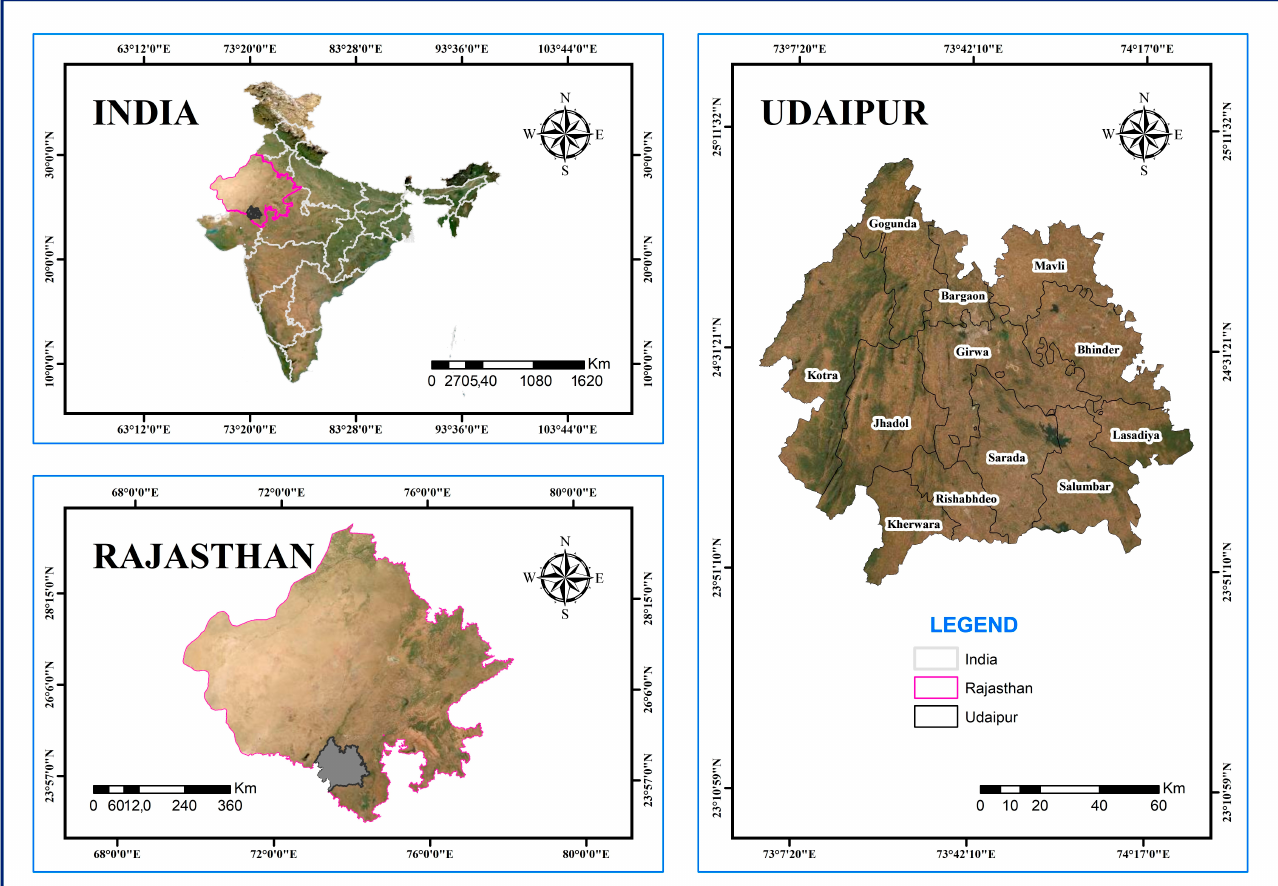
Figure 1. Location of Udaipur with respect to the State of Rajasthan and, overall, India.